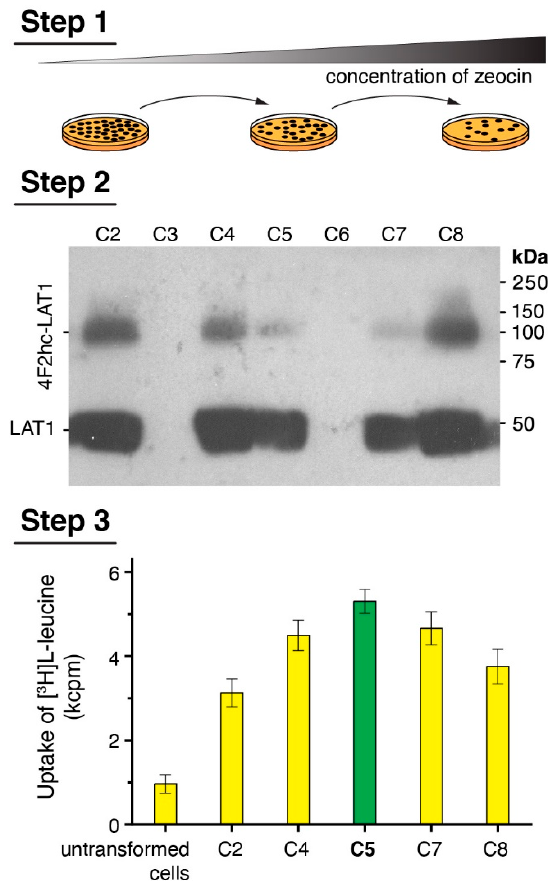
Figure 1. Scheme of the medium-throughput Pichia clone selection procedure. Step 1 depicts a cartoon of the colony picking and streaking round by increasing the Zeocin TM concentration to screen for clones with a high copy number of protein DNA sequence integrations into the Pichia genome. Step 2 displays representative experimental data obtained from a small-scale 24-well plate format protein overexpression test evaluated by Western blotting. Colonies, which show relative high protein expression levels, were selected for Step 3 . Here, Step 2 positive clones are functionally analyzed by [ 3 H]L-leucine uptake into Pichia cells. Finally, the clone displaying highest functional property (C5, green bar) was selected for large-scale overexpression runs followed by protein purification.